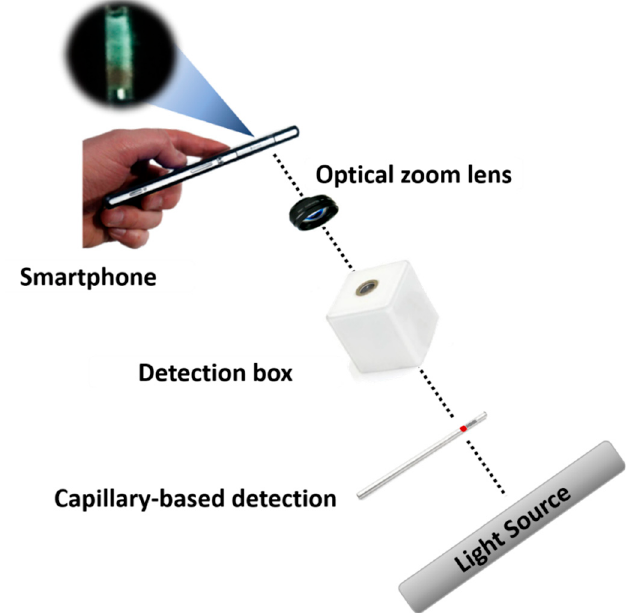
Figure 1. Illustration of an integrated platform consisting of a modified capillary device, a sandwiched immunocomplex and a portable detection system.